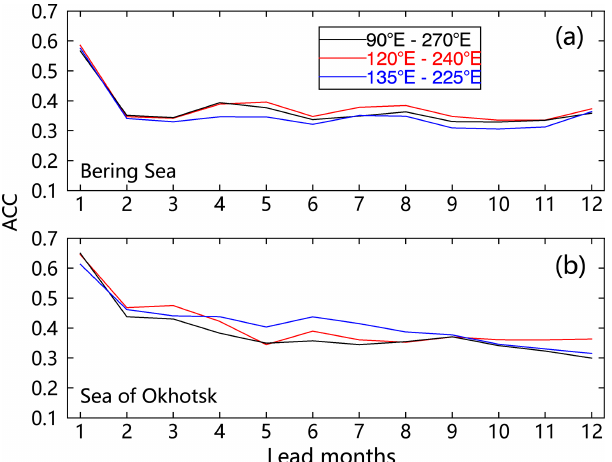
Figure 12. Cross-validated model skills of the regional Markov model with the same model configuration and different sizes of the model domain. (a) The skills are measured by the ACC be- tween predictions and observations with trends from 1980 to 2020 as a function of lead months in the Bering Sea. Panel (b) is the same as (a) except for the Sea of Okhotsk. The model is config- ured by V9M16 in winter, V11M20 in spring, V5M10 in summer, and V5M7 in autumn. The ACC values are averaged over the area marked in the black box in Fig.